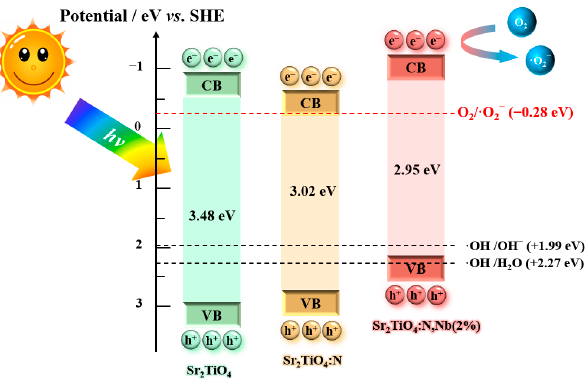
Figure 12. Schematic band structures of Sr 2 TiO 4 , Sr 2 TiO 4 :N, and Sr 2 TiO 4 :N,Nb(2%). The potential of O 2 /O − , OH/OH − , and OH/H 2 O are shown in the